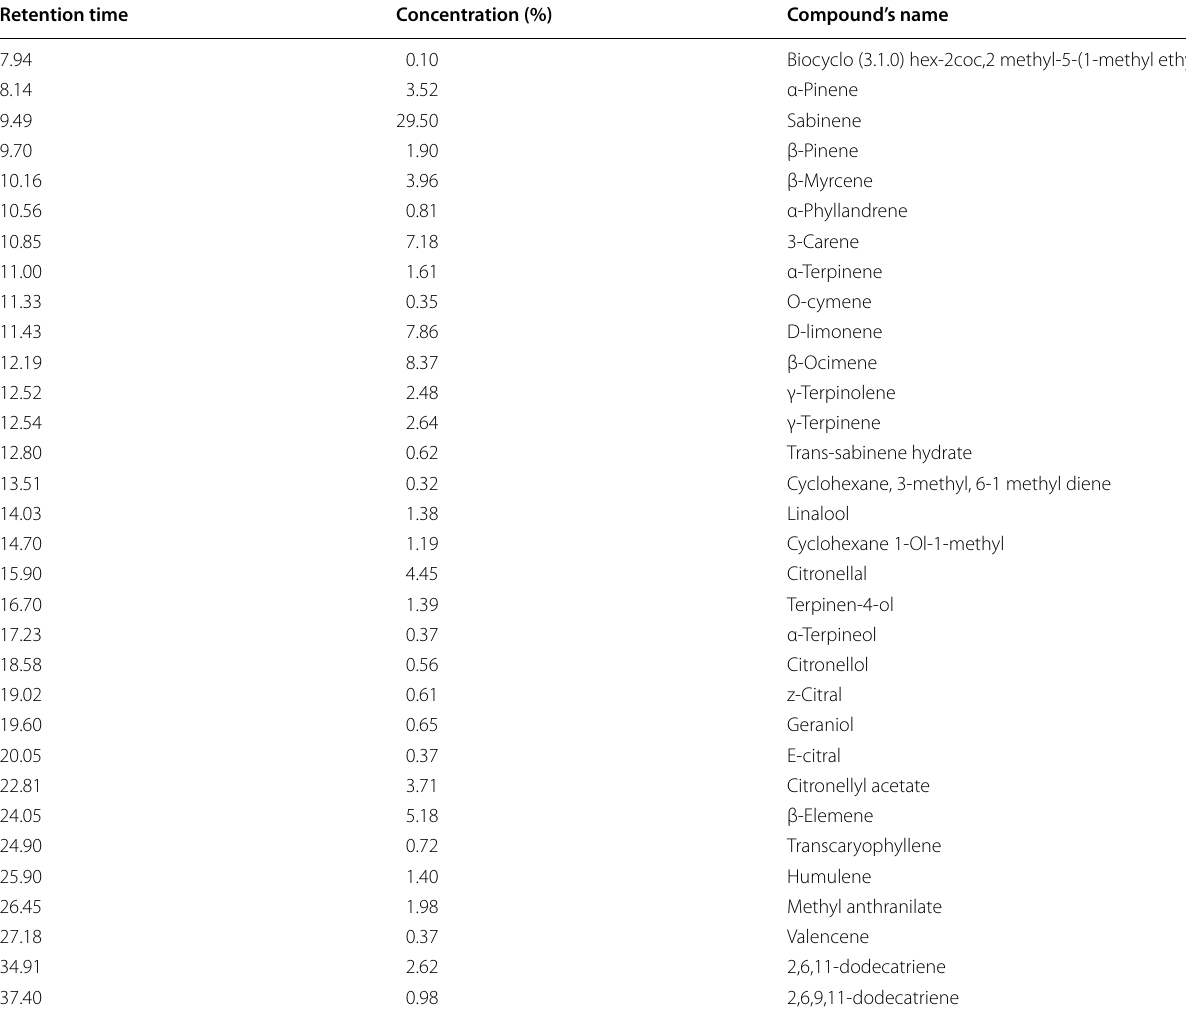
Table 1 GC–MS volatile oil of lemon leaves Retention